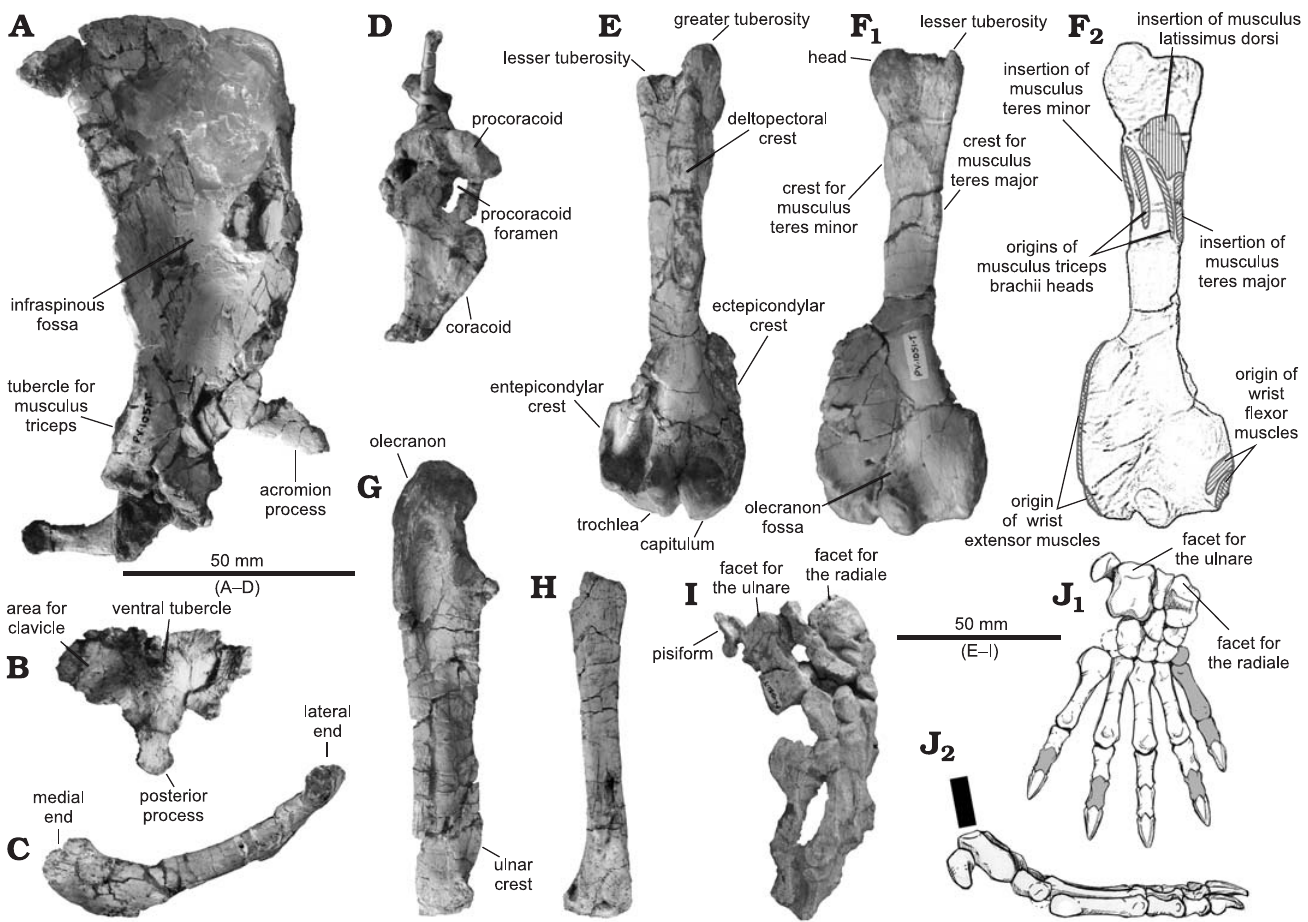
Fig. 3. Pectoral appendicular skeleton of non-mammalian cynodont Trucidocynodon riograndensis Oliveira, Soares, and Schultz, 2010 (UFRGS PV- 1051-T) from Carnian (Upper Triassic) of Agudo municipality, state of Rio Grande do Sul, Brazil. A – D . Pectoral girdle; right scapulocoracoid in lateral ( A ) and ventral ( D ) views; right clavicle in dorsal view ( C ); interclavicle in ventral view ( B ). E – J . Forelimb; left humerus in anterior ( E ) and posterior ( F ) views (F 1 , photograph; F 2 , interpretation of the attachment areas of some muscles); right ulna ( G ) and right radius ( H ) in lateral view; right hand in dorsal view ( I ). J . Reconstruction of the hand in dorsal (J 1 ) and lateral (J 2 ) views (gray-shaded bones were not preserved; the black bar in J 2 represents the potential orientation of the forearm